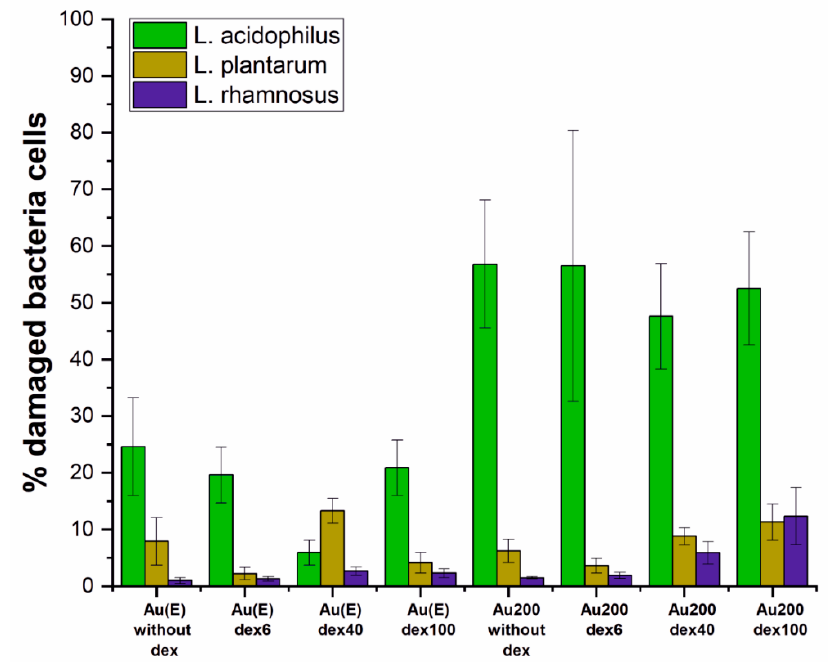
Figure 7. Contribution of damaged bacteria in the population that colonized the surfaces after 24 h of culture based on the live/dead staining for the fluorescent microscopy.